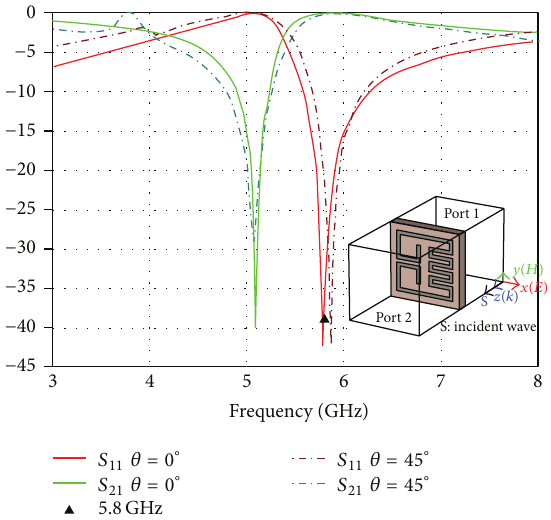
Figure 6: Reflection and transmission coefficient in dB of FL-LHM unit-cell under an incident wave at angle of 0 ∘ and 45 ∘ .